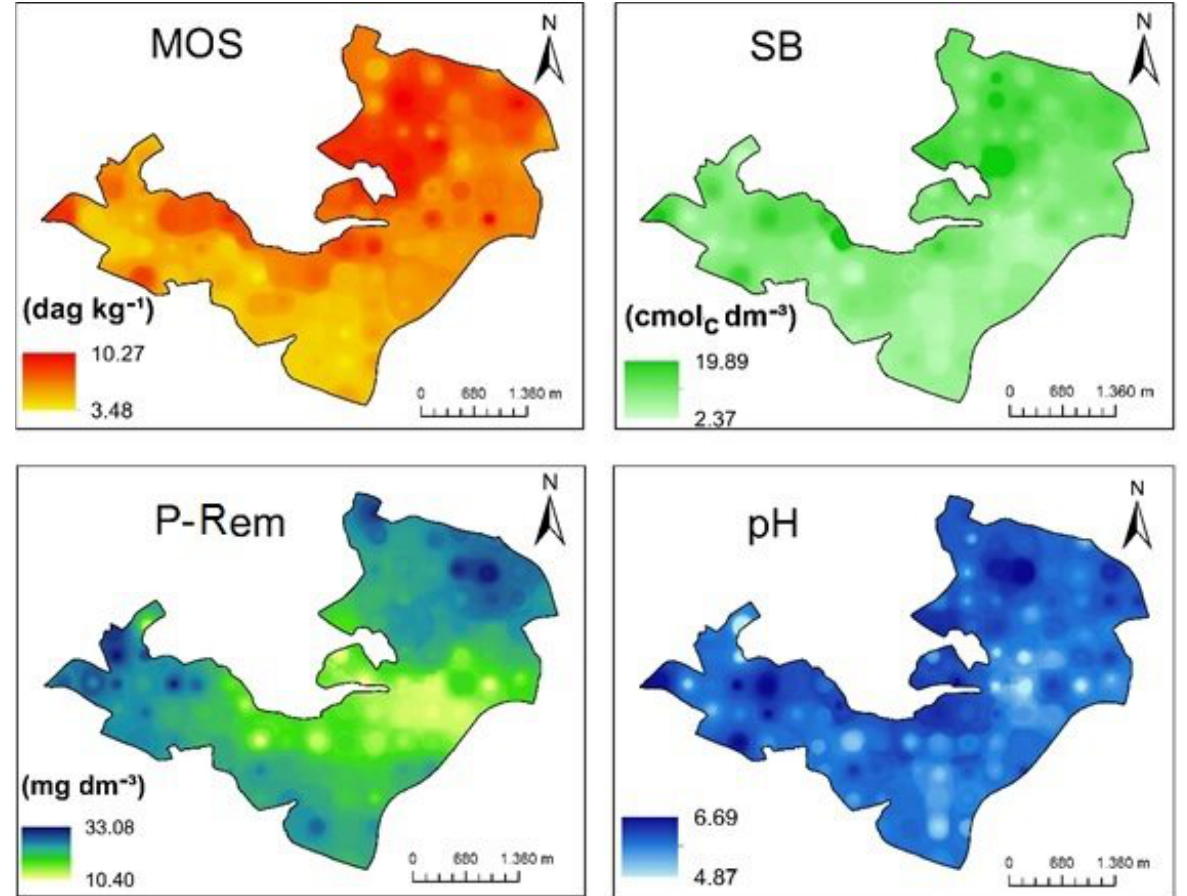
Figure 6. Prediction maps for soil attributes (0-20 cm) via Random Forest from pXRF data obtained from samples collected at Lavras, Minas Gerais, Brazil. SOM: soil organic matter; SB: sum of bases; P-Rem: remaining